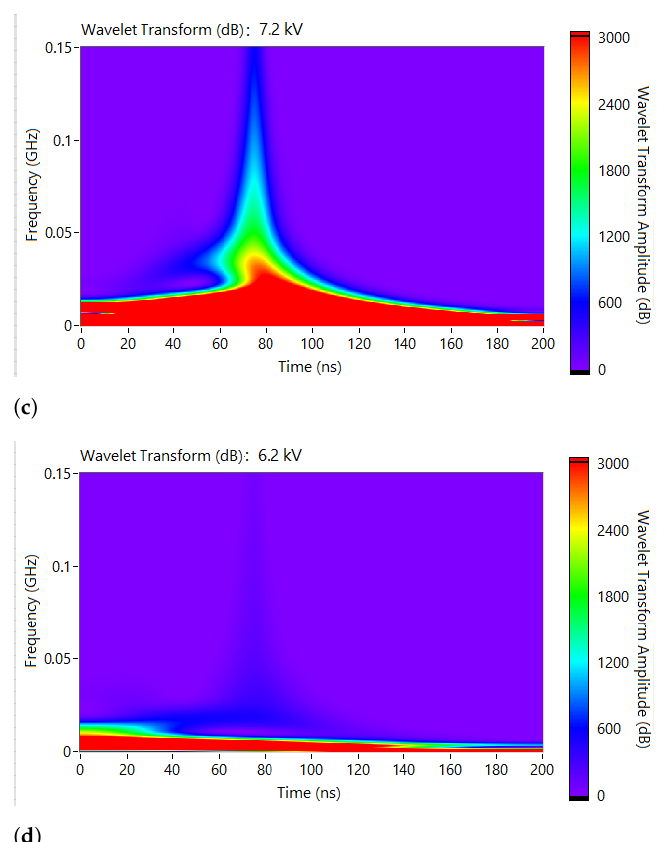
Figure 4. Discharge current pulses: ( a ) evolution of waveforms over time (8.2 kV, 7.2 kV and 6.2 kV pulses) [25], ( b ) wavelet transform of the 8.2 kV pulse, ( c ) wavelet transform of the 7.2 kV pulse, and ( d ) wavelet transform of the 6.2 kV